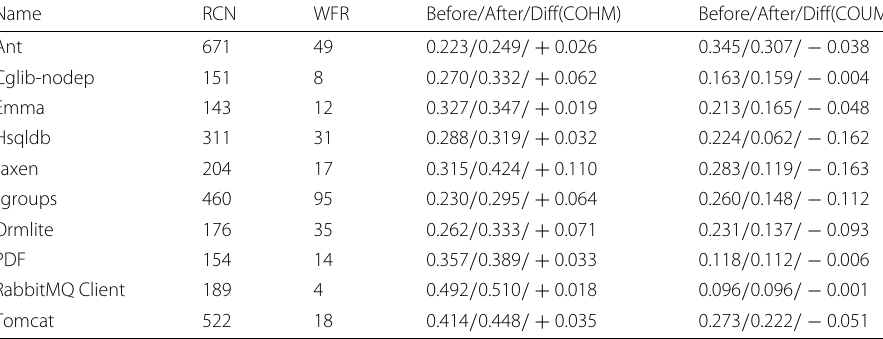
Table 2 Improvement of our metrics after